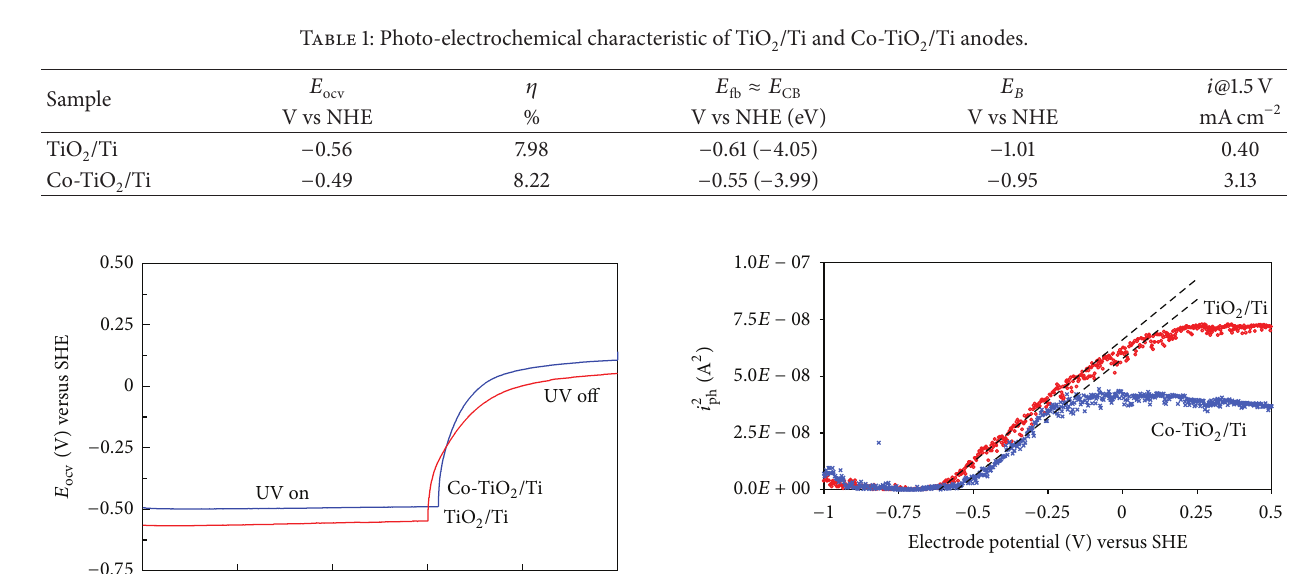
Figure 7: Square photocurrent versus electrode potential for TiO 2 /Ti ( × ) and Co-TiO 2 /Ti ( ∘